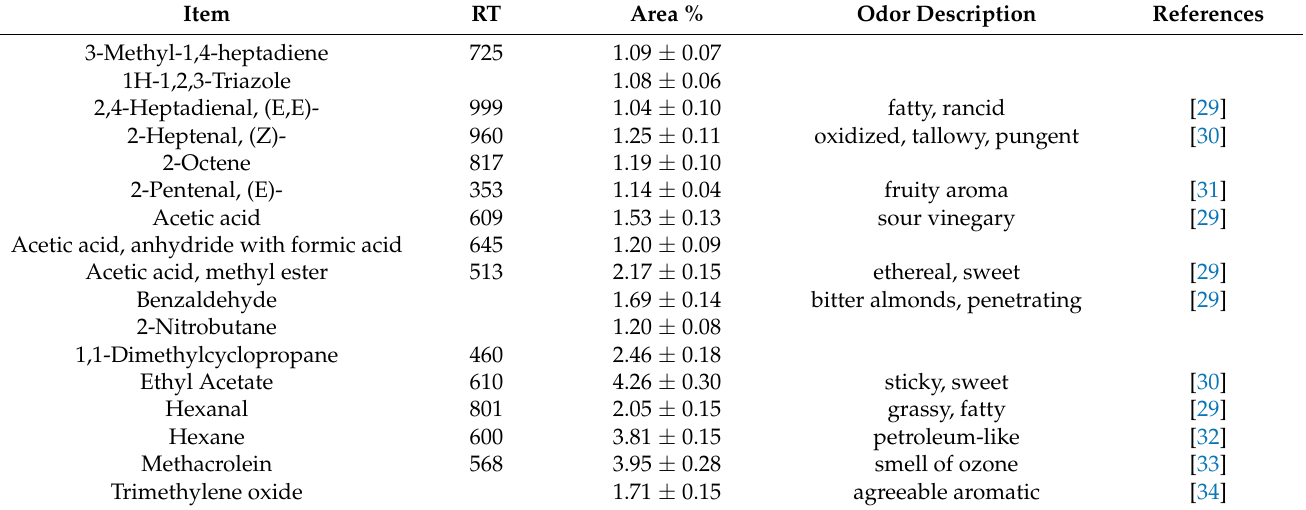
Table 5. Percentage composition of volatile compounds from blueberry seed oil obtained by sonification.